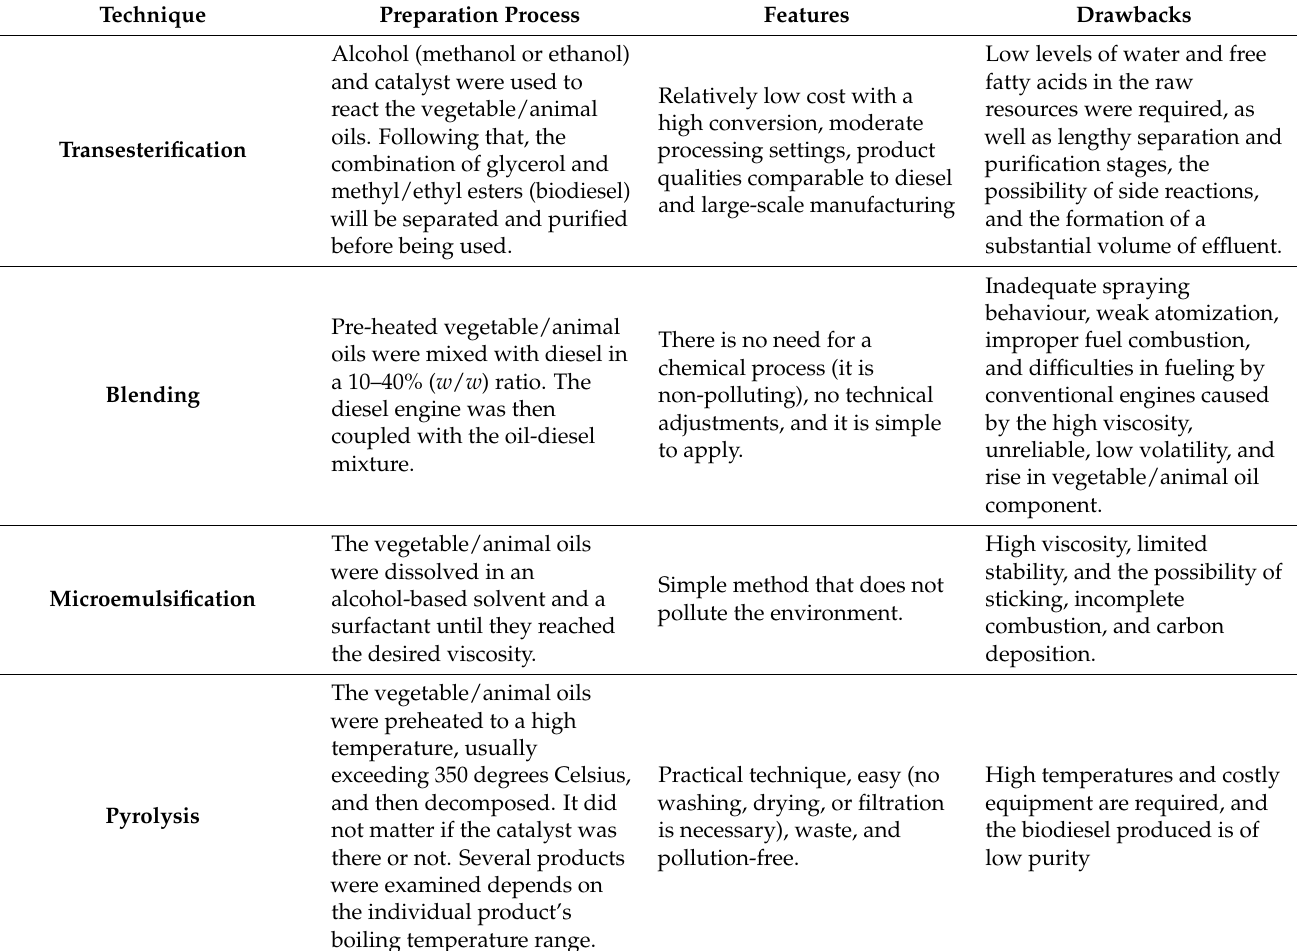
Table 2. A summary of alternative biodiesel preparation approaches